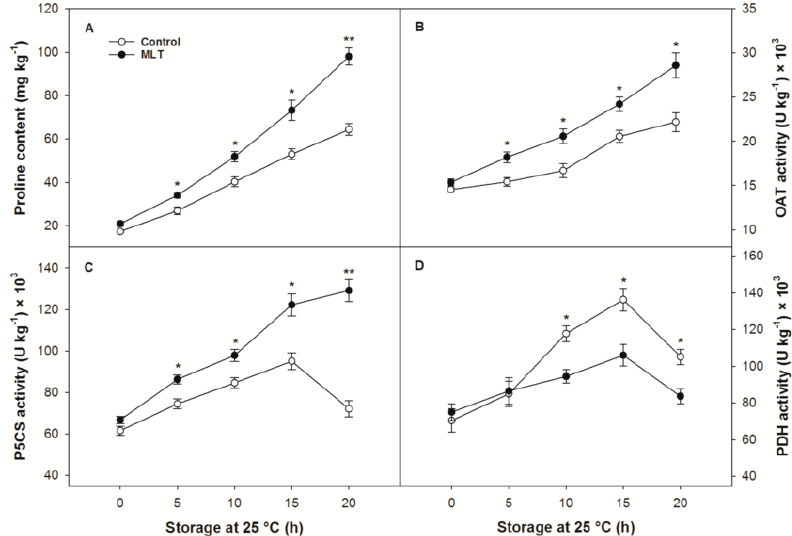
Figure 6. ( A ) proline content and activities of ( B ) ornithine- δ -aminotransferase (OAT), ( C ) Δ 1 -pyrroline-5-carboxylic acid synthase (P5CS) and ( D ) proline dehydrogenase (PDH) of the control and MLT-treated litchi (cv. Baitangying) fruit during storage at 25 ◦ C after 15 d of refrigeration at 5 ◦ C. The bars represent the SEs of the means ( n = 3). The asterisks indicate that the values are significantly di ff erent between groups at the same time point (* p < 0.05, ** p <